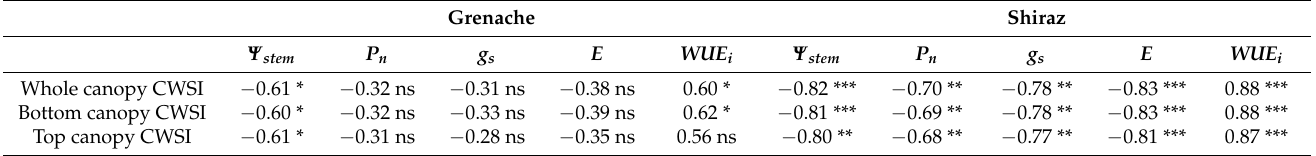
Table 3. Pearson correlation analysis between the CWSI and the physiological parameters. Each cell contains the value of the coefficient of determination. Single asterisk indicates a significant correlation, p < 0.05; double asterisk indicates a significant correlation, p < 0.01; triple asterisk indicates a significant correlation, p < 0.001; ns indicates a not-significant correlation ( p > 0.05). Grenache Shiraz